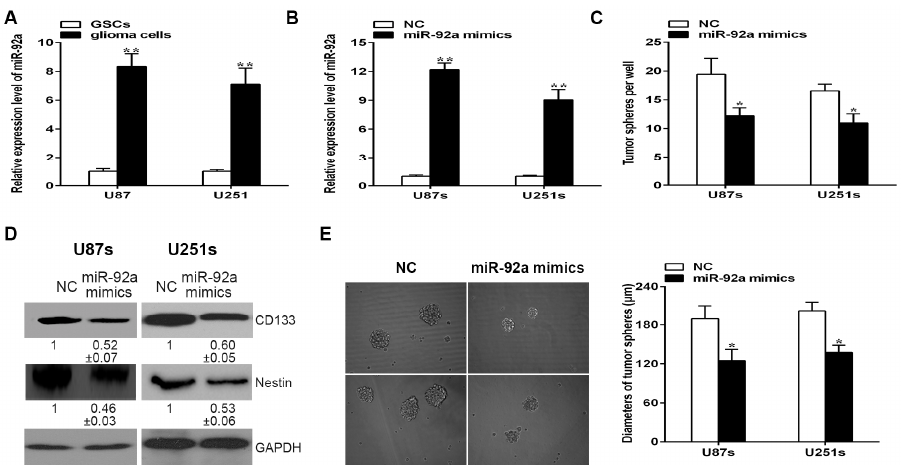
( B ) Representative immunofluorescence staining images of CD133 (green) and nestin (red) in GSCs; ( C ) Representative immunofluorescence staining images of GFAP (red) and β -tubulin-III (green) in differentiated cells. Nuclei were counterstained with DAPI (blue) as a control. Images were photographed at 100× original magnification. All images are representative of three independent experiments images. Scale bar represents 200 µm.